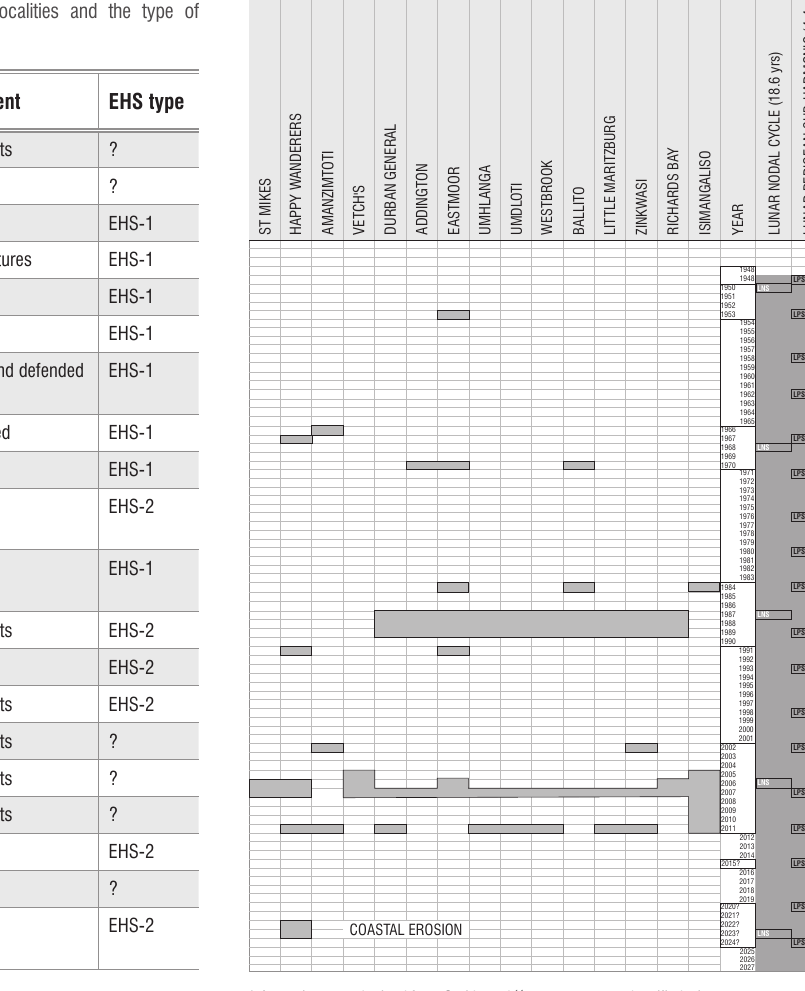
Information was obtained from Smith et al. 14 , newspapers and verified witnesses. Figure 4: Coastal erosion events since 1949 at known KwaZulu-Natal erosion hotspot localities. Erosion clearly correlates with years in which the LPS and LNC lunar tidal cycles peak (although the latter dominates) – times of unusually high spring tides (Figure 4). This evidence is empirical and the exact causal relationship needs to be better established. Whether the moon is influencing coastal erosion directionally through increased tidal current action 21,22 or indirectly by influencing the weather (and hence the swell climate) 23-26 has yet to be ascertained. Geofabric bag defences emplaced after the 2006/2007 erosion event tolerance) and geofabric sandbag filled gabions failed. Some